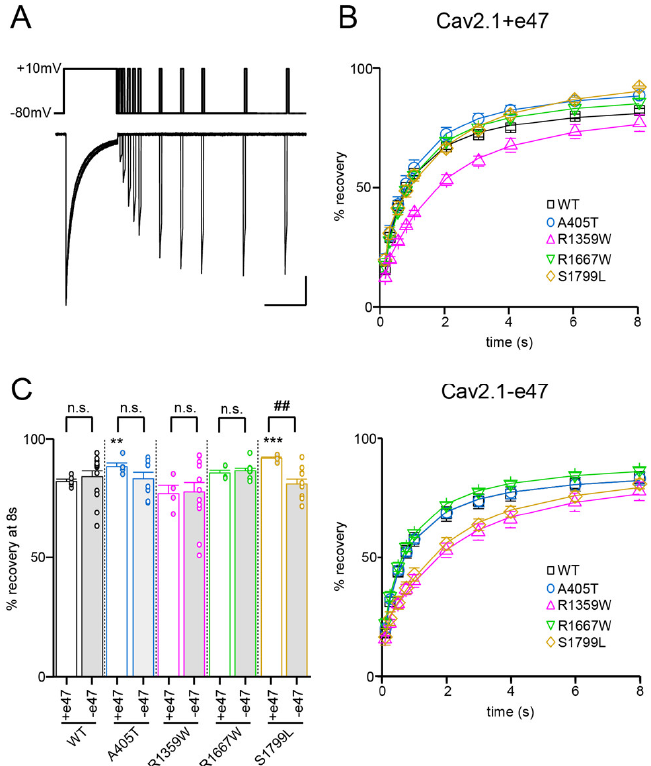
Figure 6. Recovery from inactivation of Cav2.1 variants. ( A ) Representative current traces were obtained in X. laevis oocytes expressing Cav2.1+47 with Cavβ4a and Cavα2δ1. The experimental protocol, illustrated above traces, consists of a 2.5 s-long depolarization to +10 mV, followed by inter-pulse intervals between 100 ms and 8 s, and a second 100 ms-long depolarization to + 10 mV. Scale bars: 200 nA and 2 s. ( B ) Percentage of current recovery plotted against the inter-pulse duration for Cav2.1+e47 ( top ) and Cav2.1−e47 variants ( bottom ). ( C ) Bar graph showing percent recovery at 8 s for all Cav2.1 variants studied. Asterisks and number signs denote significant differences vs. WT (** p < 0.01, *** p < 0.01) and vs. Cav2.1+e47 (## p < 0.01), respectively (non-paired Student’s t -test). n.s. = non-significant.